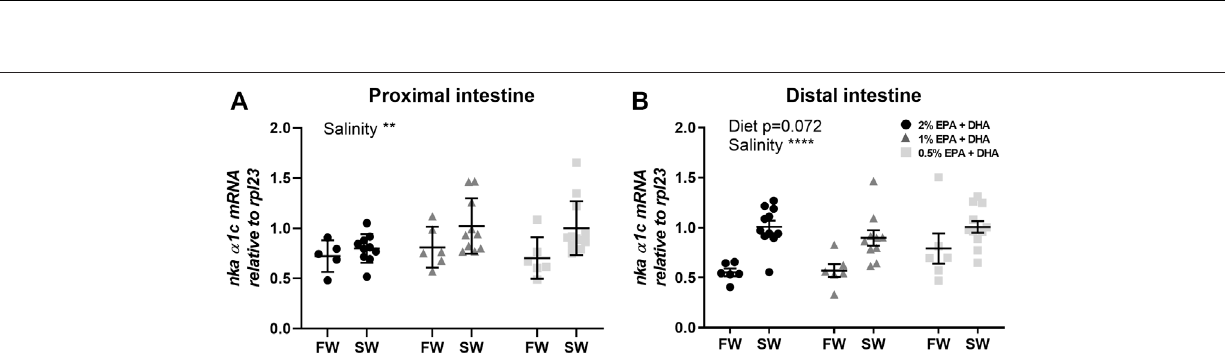
Frontiers in Physiology |